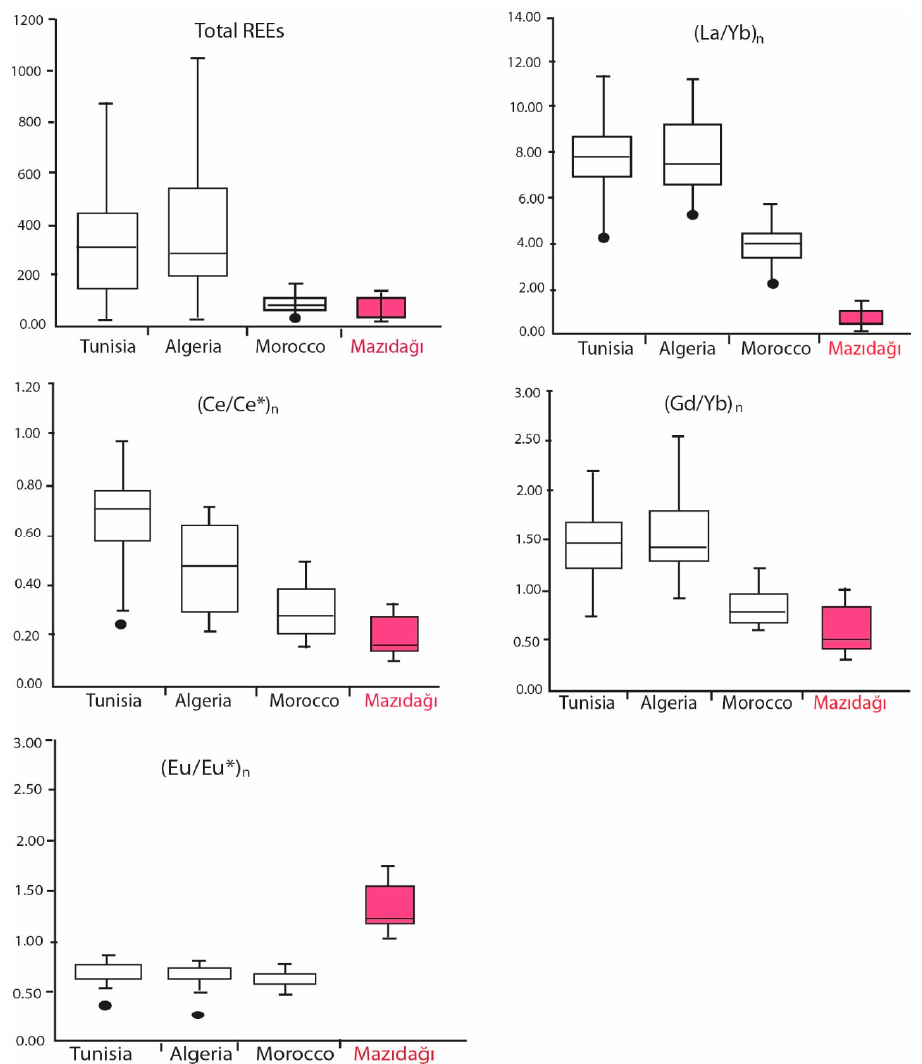
Figure 10. Comparison of the REE, (La/Yb) n , (Ce/Ce*) n , (Gd/Yb) n , and (Eu/Eu) n parameters in the Tunisian, Algerian, Moroccan, and Maz ı da ğ ı phosphates. Data from [85]. The horizontal bar in the box refers to the median value; the ends of the whiskers are the maximum and minimum values of variables; the top and bottom of the boxes are the values of the first and third quartiles; circles represent the outlier values of the data set.